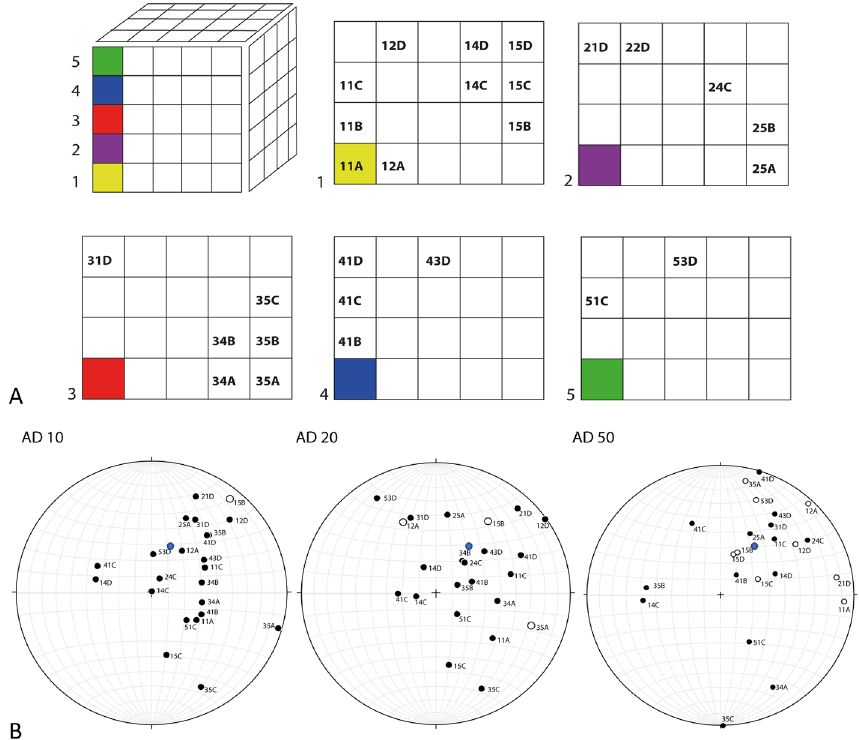
Figure 2. ( A ) Map of the cube labels for individual cubes that survived intact the cutting procedure (many cubes disintegrated during the cutting) of the rock sample in Fig. 1B. ( B ) Stereonet plots are showing orientation of the magnetizations from each of the cube mapped in A. Stereonet plots are labeled by AD 10, AD 20 and AD 50. Plot AD 10 shows each of the cubes’ magnetizations after demagnetization by alternating field of 10 A/m. Plots AD 20 and AD 50 show demagnetizations by 20 A/m and 50 A/m respectively. Blue dots in each stereoplot is direction of today’s